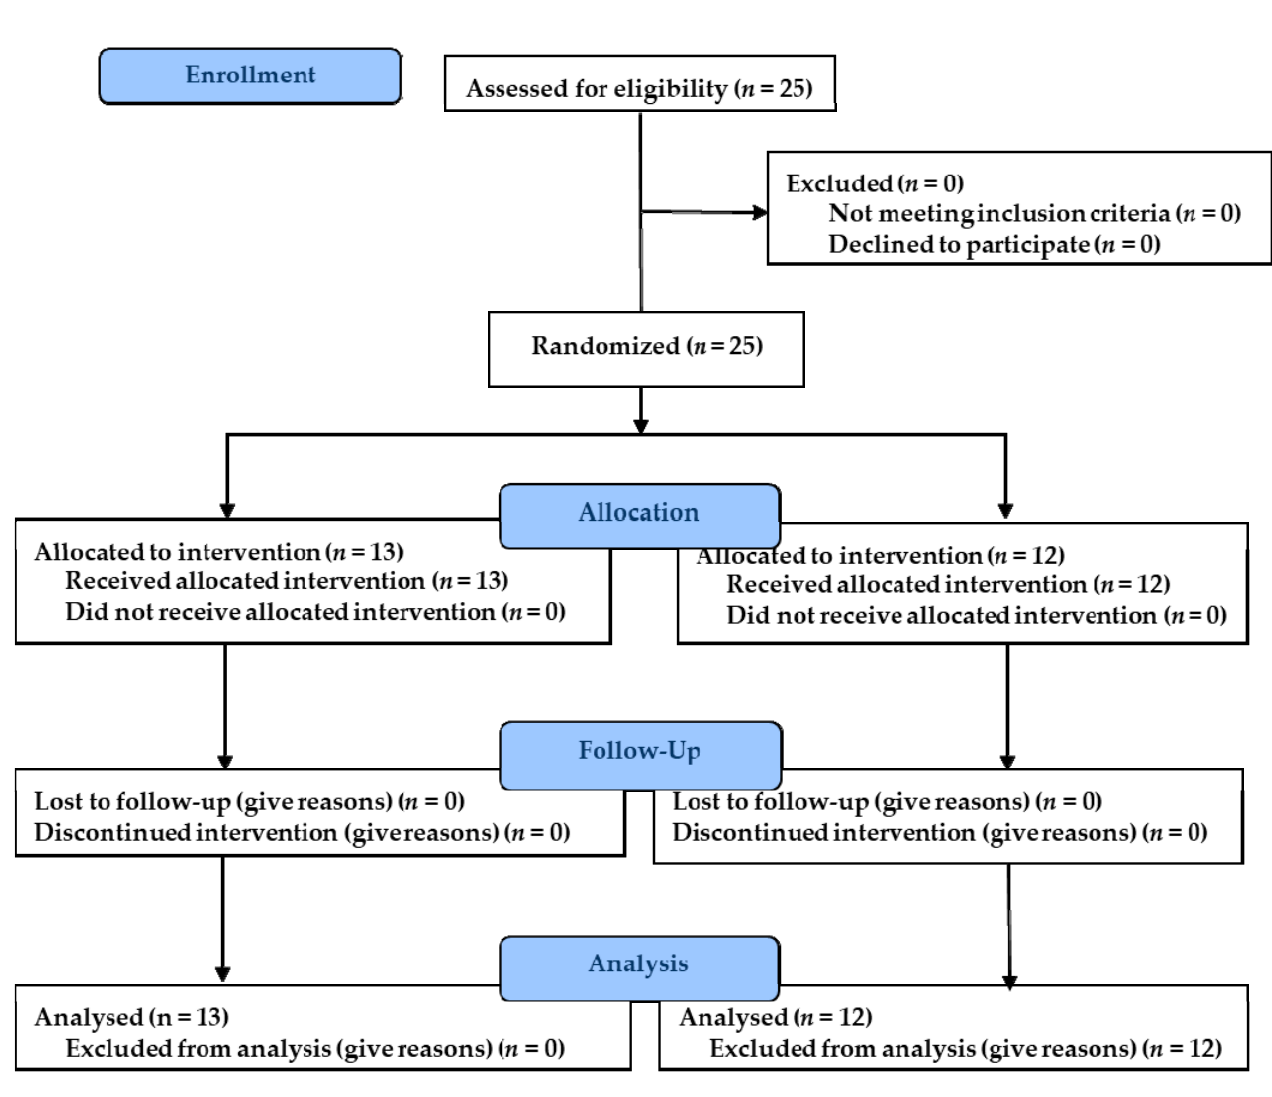
Figure 1. Flowchart of the study.